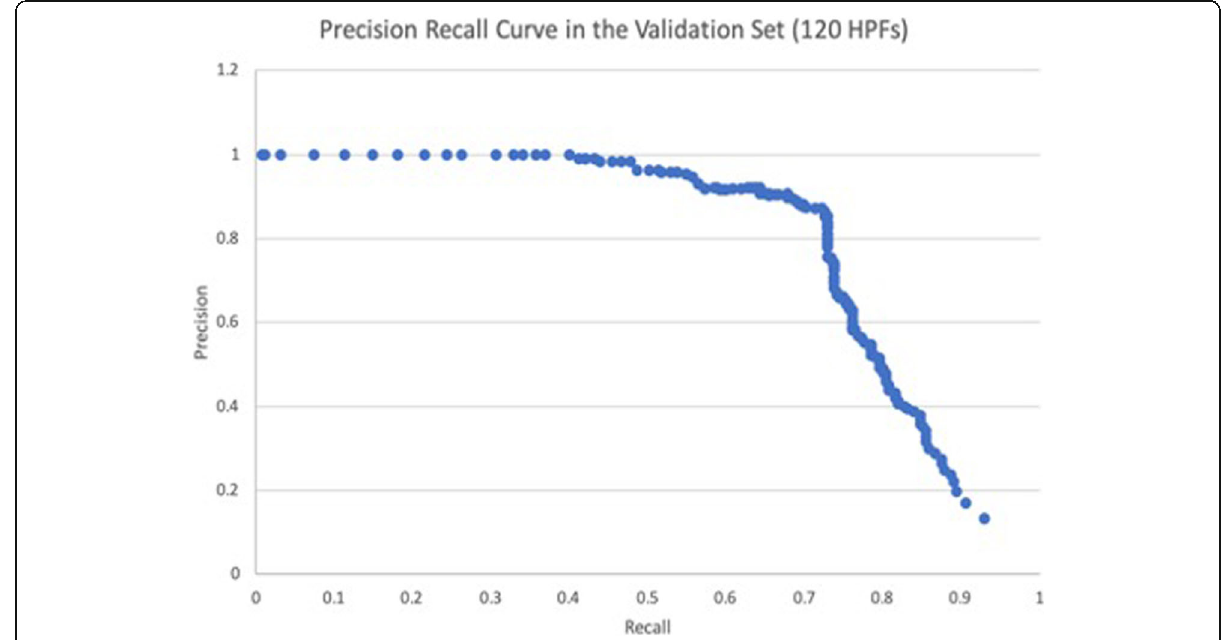
Fig. 3 Algorithm performance for mitotic figure detection in the analytical validation